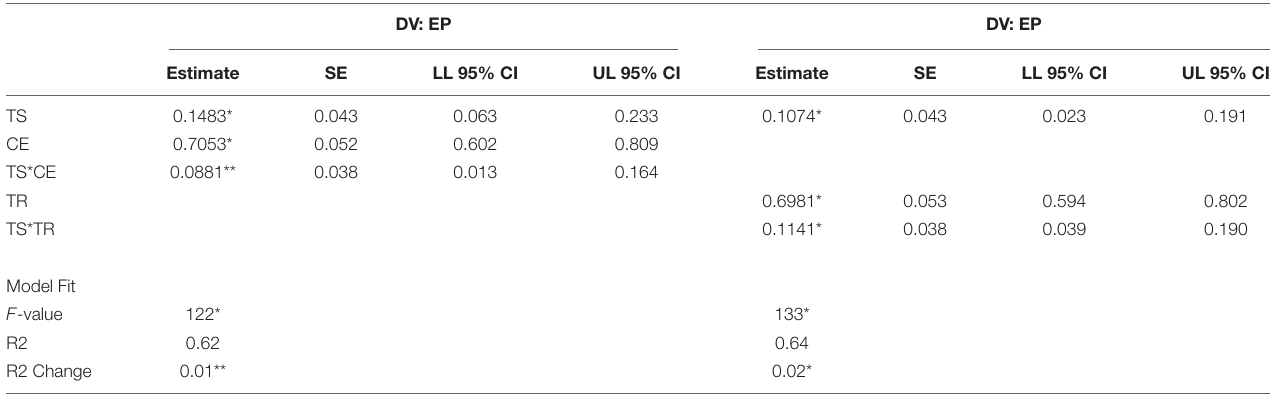
TABLE 5 | 5000 Bootstrap Results for PROCESS Model No.1, simple moderation analysis.